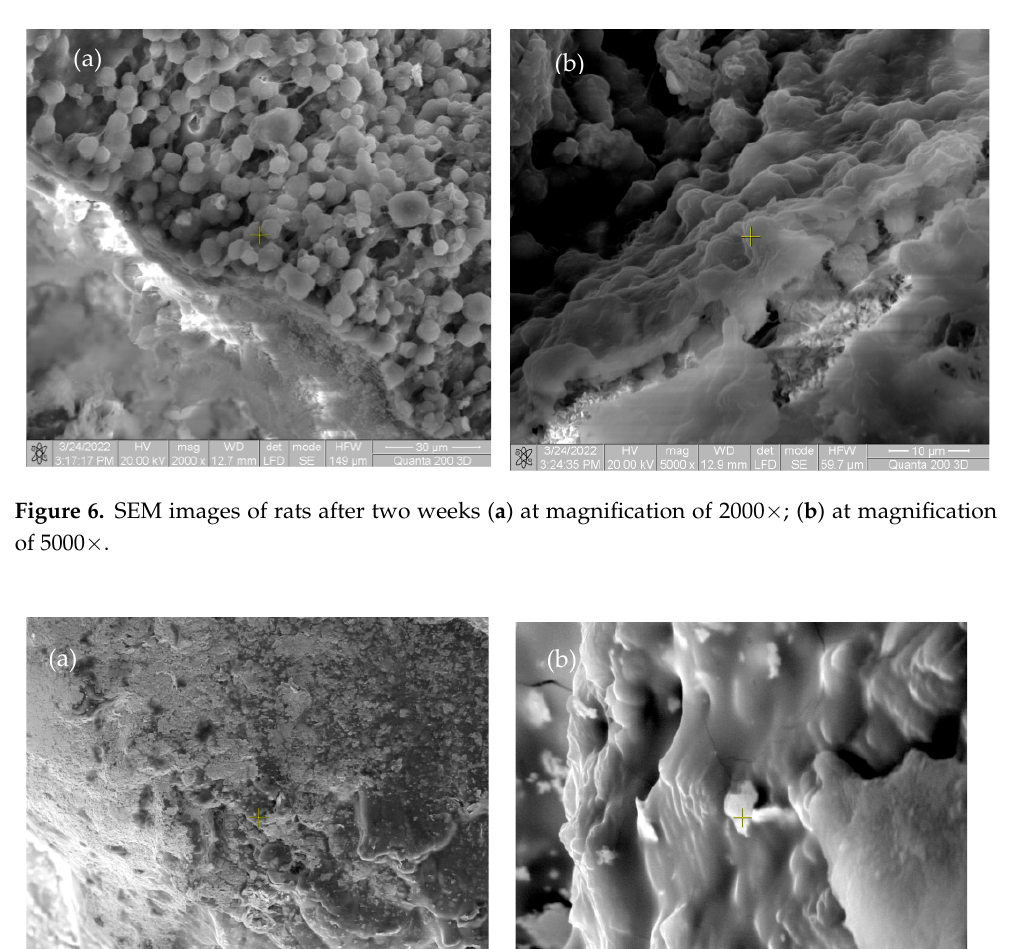
Figure 5. SEM images taken of rats after one week in ( a ) at magnification of 2000×; ( b ) at magnifica- tion of 5000×.